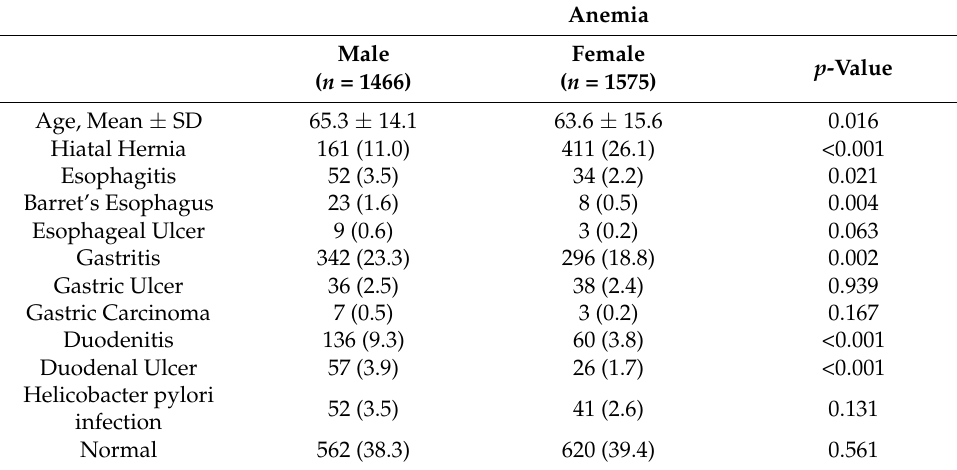
Table 4. Upper endoscopy findings for the indications of anemia.